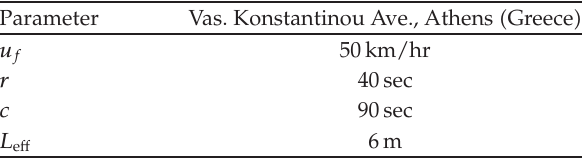
Table 1: Parameter values used for congestion detection.